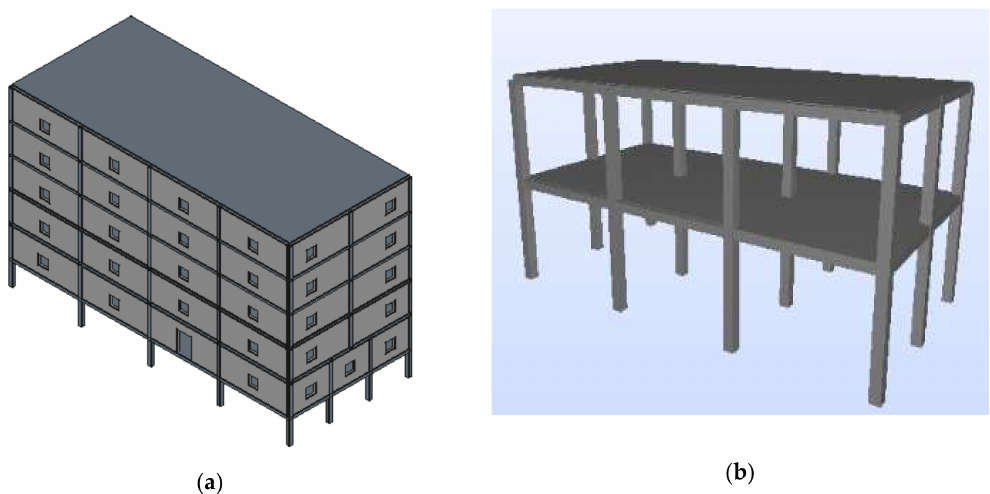
Figure 4. ( a ) BIM Architectural Model and ( b ) BIM Structural